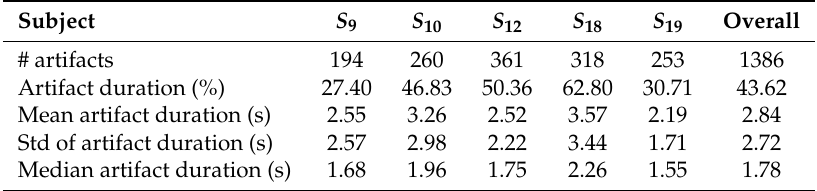
Table 3. Number of artifacts manually detected and their main